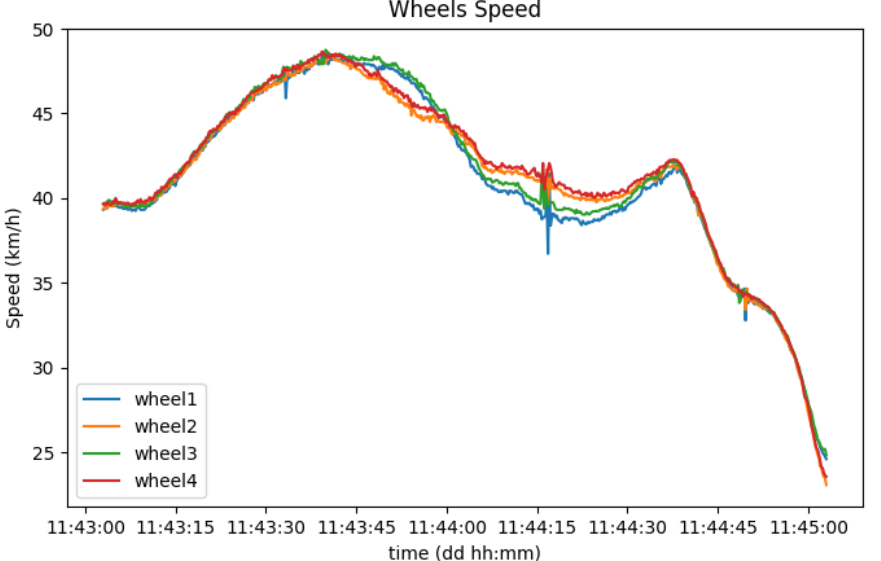
Figure 17. Variation of each wheel speed through a sharp